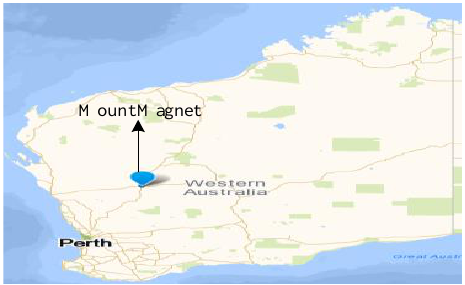
Figure 1. Mount Magnet in Western Australia.